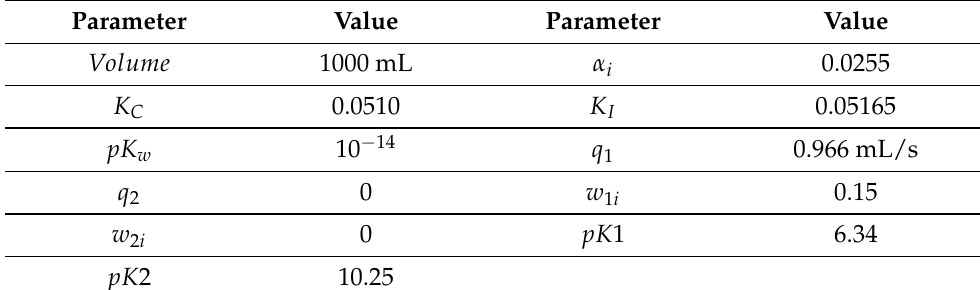
Table 3. Parameters for simulation tests.